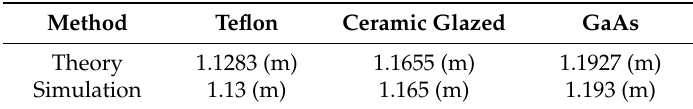
Table 2. Comparison between theoretical calculations and simulation results.